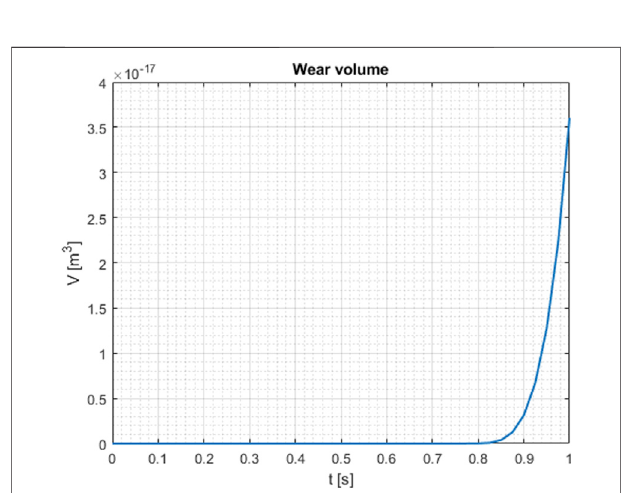
FIGURE 11 | Wear volume time